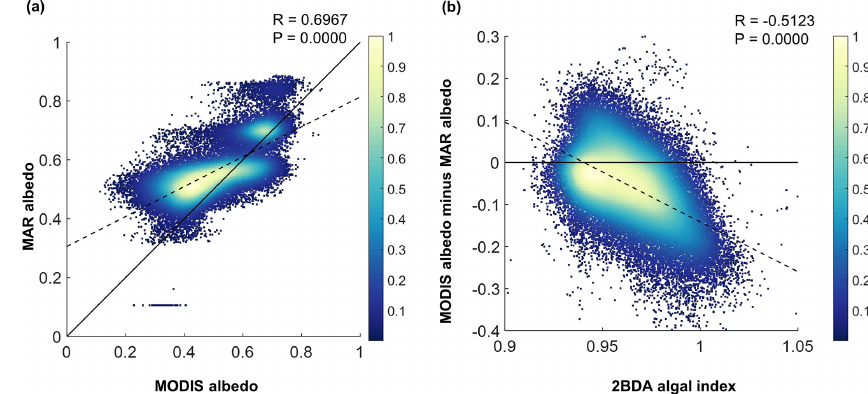
Figure 11. (a) Comparison between MAR albedo and MODIS albedo over the study area for July and August from 2004 to 2011. The dashed line shows the linear fit between MODIS albedo and MAR albedo. The black line is the 1 : 1 reference line. (b) Relationship between the MERIS 2BDA index and the albedo difference between MODIS and MAR, with the dashed line showing the linear fit. The color scheme in both (a) and (b) illustrates the relative data distribution density (yellow means higher density, and blue means lower density).